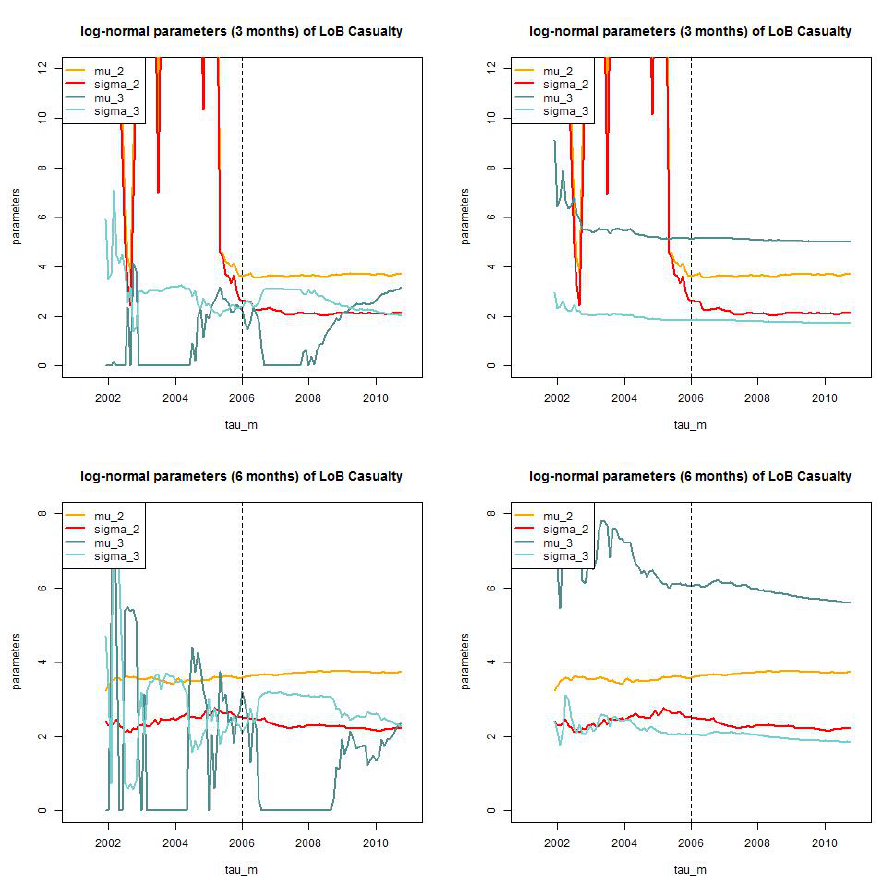
Figure 13. LoB Casualty: parameter estimates of ( µ 2 , σ 2 , µ 3 , σ 3 ) for the static model α = 0 for τ m ∈ { 31/12/2010, . . . ,31/10/2010 } (top, lhs) u ( 2 ) = 3 months truncated/truncated and (top, rhs) and truncated/shifted; and (bottom, lhs) u ( 2 ) = 6 months truncated/truncated (bottom, rhs) and